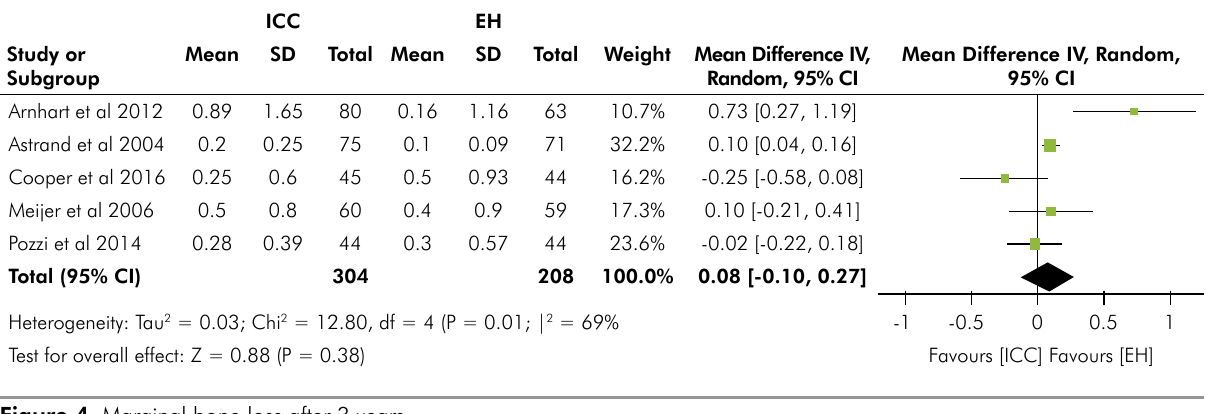
Figure 4. Marginal bone loss after 3 years.